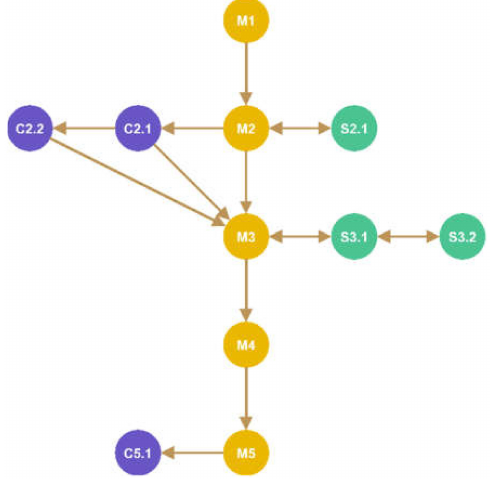
Figure 3. A complete learning graph (LG) is shown as it is seen in the web portal, displaying the mandatory main tasks (yellow). The support (green) and challenge (purple) tasks are accessed by the user as indicated by the edges connecting the task